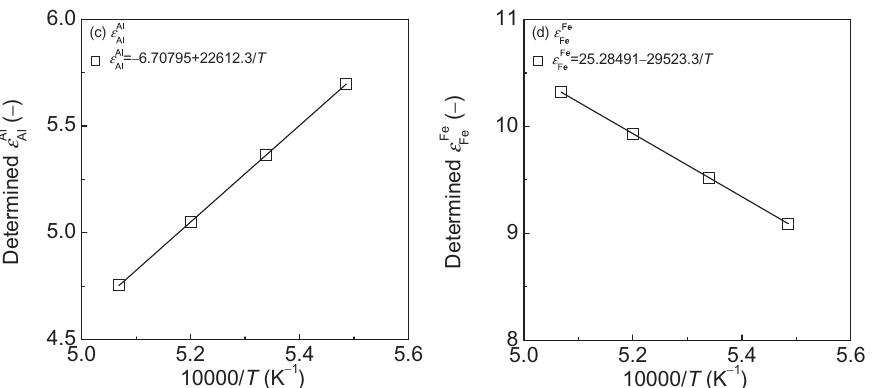
coupled with activity Al